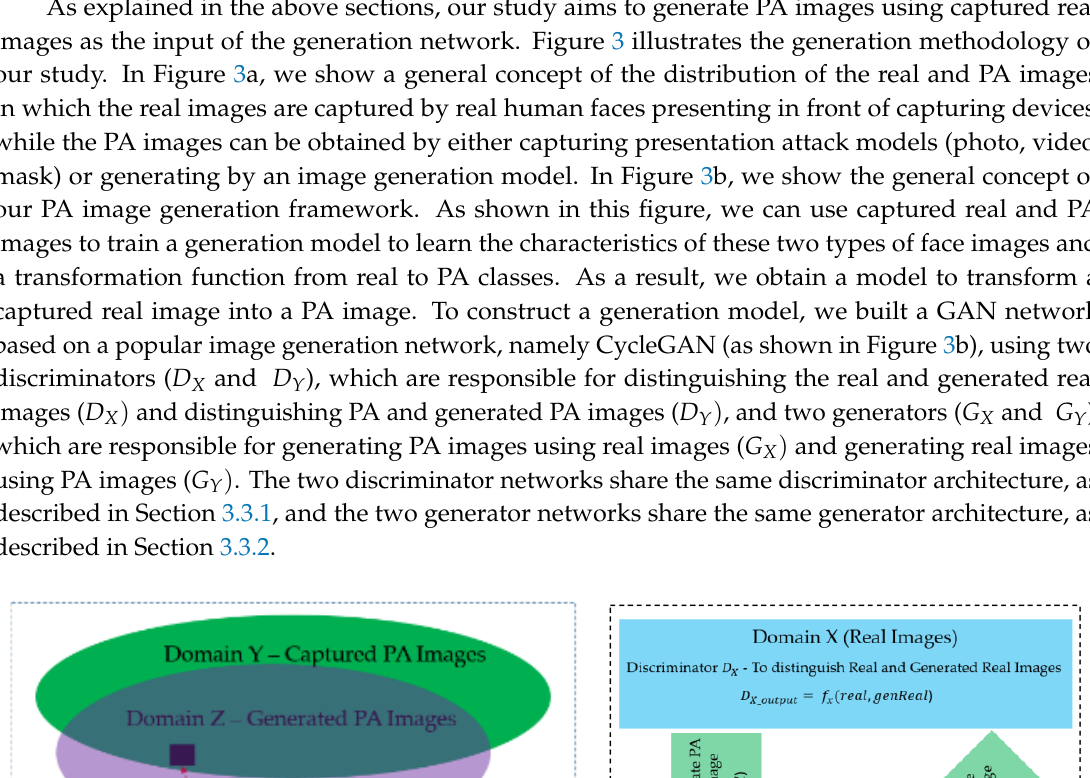
Figure 2. Methodology and an example result of face detection and misalignment compensation steps: ( a ) overview of method for face detection and in-plane rotation compensation with input captured face image (left) and result image (right); ( b ) example results.